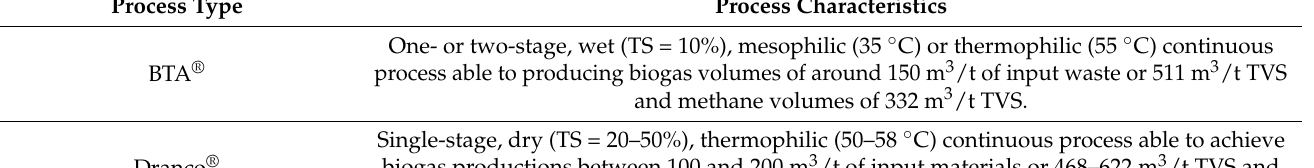
Table 1. Types and characteristics of commercial organic fraction of municipal solid waste (OFMSW) anaerobic digestion (AD) technologies. HRT—hydraulic retention time. Process Type Process